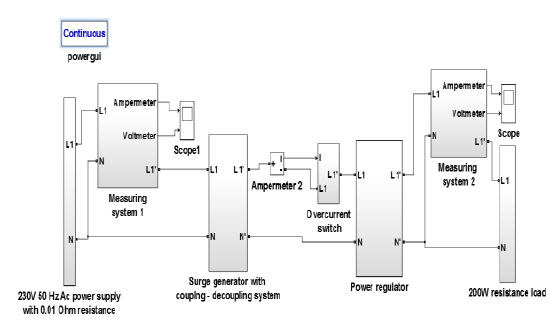
Fig. 1. Scheme of the simulated system . On the voltage characteristic considered on the load side (measuring system 2) during the pulse disturbance, a pulse with an magnitude of 1280 V is visible (Fig. 2). shape of the voltage. The magnitude of the current pulse resulting from the introduced disturbance is about 7.8 A (fig. 3).